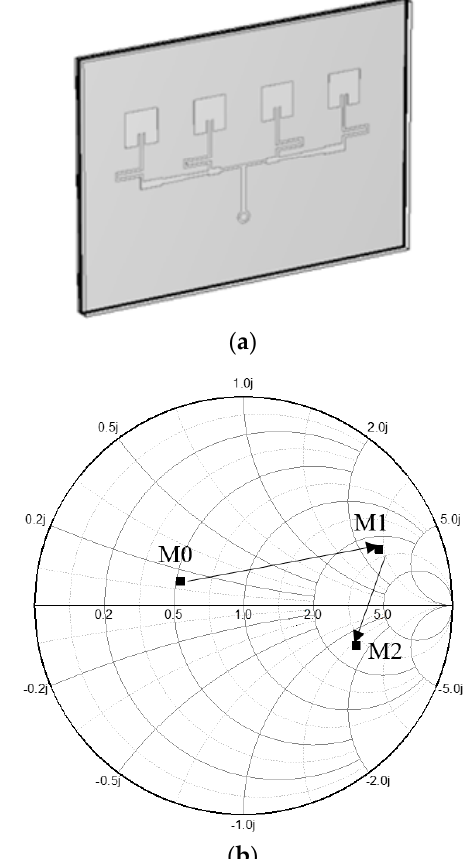
Figure 7. The Smith chart plot presenting the impedance of the resonator array: M0 as the array alone, M1 with the back − cover loaded and M2 with the COP film added. ( a ) Structure. ( b ) Smith chart.